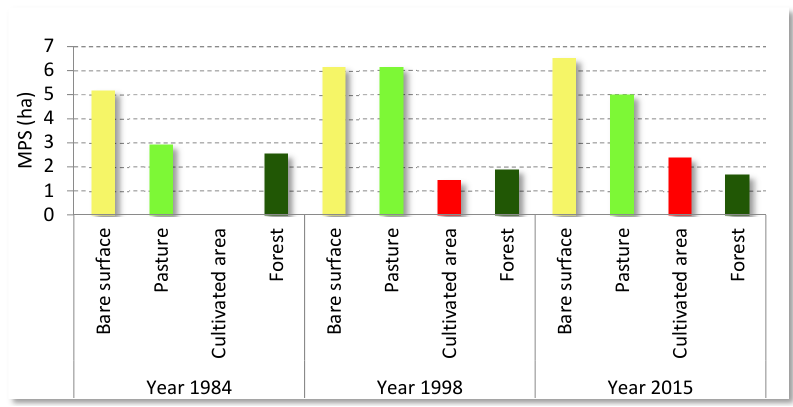
Figure 6. Mean patch size (MPS) for land use/land cover classes of the HSCZ at three different times.